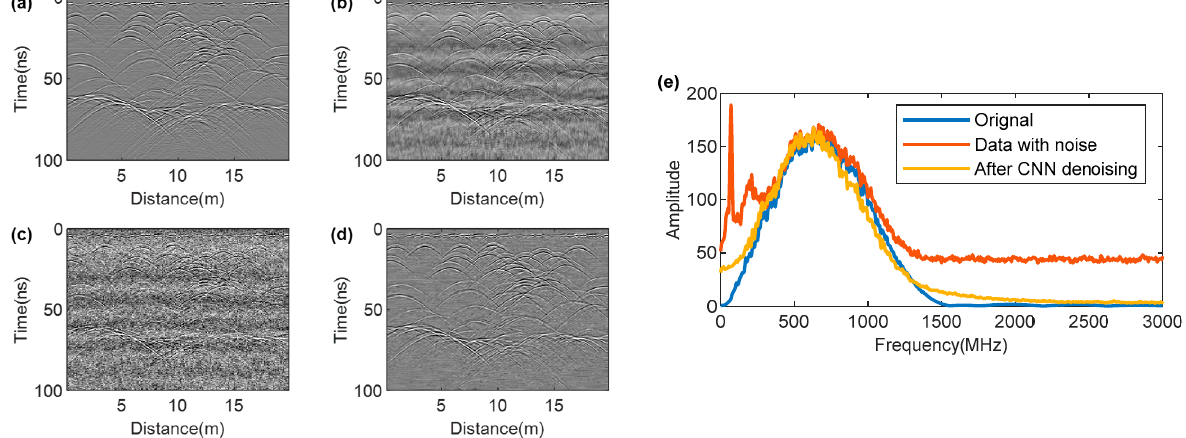
Figure 10. Model denoising test. ( a ) Simulated data; ( b ) data with low-frequency clutters; ( c ) data with low-frequency clutters and high-frequency noises; ( d ) denoising result; ( e ) comparison of average frequency amplitude spectrum.